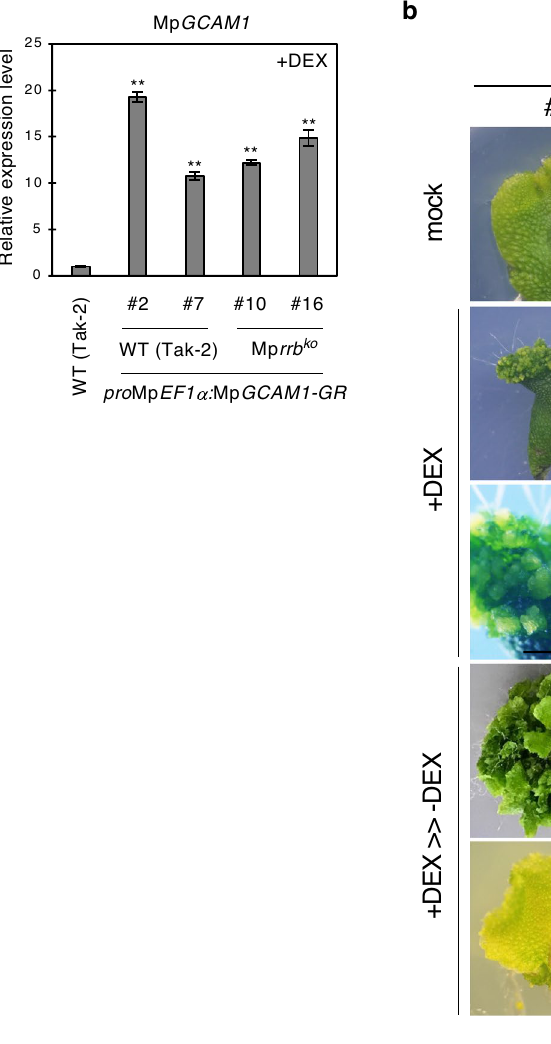
Figure 5. Morphological phenotype of the Mp rrb knockout lines overexpressing Mp GCAM1 . ( a ) Transcript levels of Mp GCAM1 in the wild-type (Tak-2) and Mp rrb that overexpress Mp GCAM1 . Thalli were treated with 5 µM DEX for 14 days. mRNA levels were normalized to that of Mp EF1α . Data are presented as mean ± SD ( n = 3). Significant differences from the wild-type (Tak-2) were determined by the Student’s t-test as follows: ** P < 0.01. ( b ) Thalli of the wild-type and Mp rrb , which carry pro Mp EF1α: Mp GCAM1–GR , were treated with (+ DEX) or without (mock) 5 µM DEX for 14 days. The DEX-treated thalli were transferred onto a medium without DEX and were further cultured for 28 days (+ DEX > > − DEX). The lower panels for DEX-treated and recovered samples are magnified images of cell clumps in the tip region and regenerated thalli, respectively. Bars represent 2